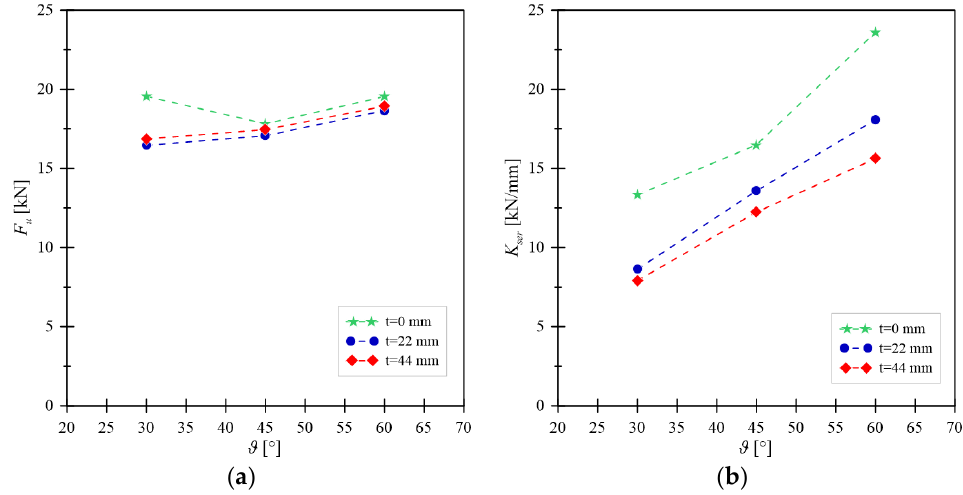
Figure 9. FE numerically predicted trends for ( a ) F u and ( b ) K ser for different values of inclination angles and interlayer thicknesses.